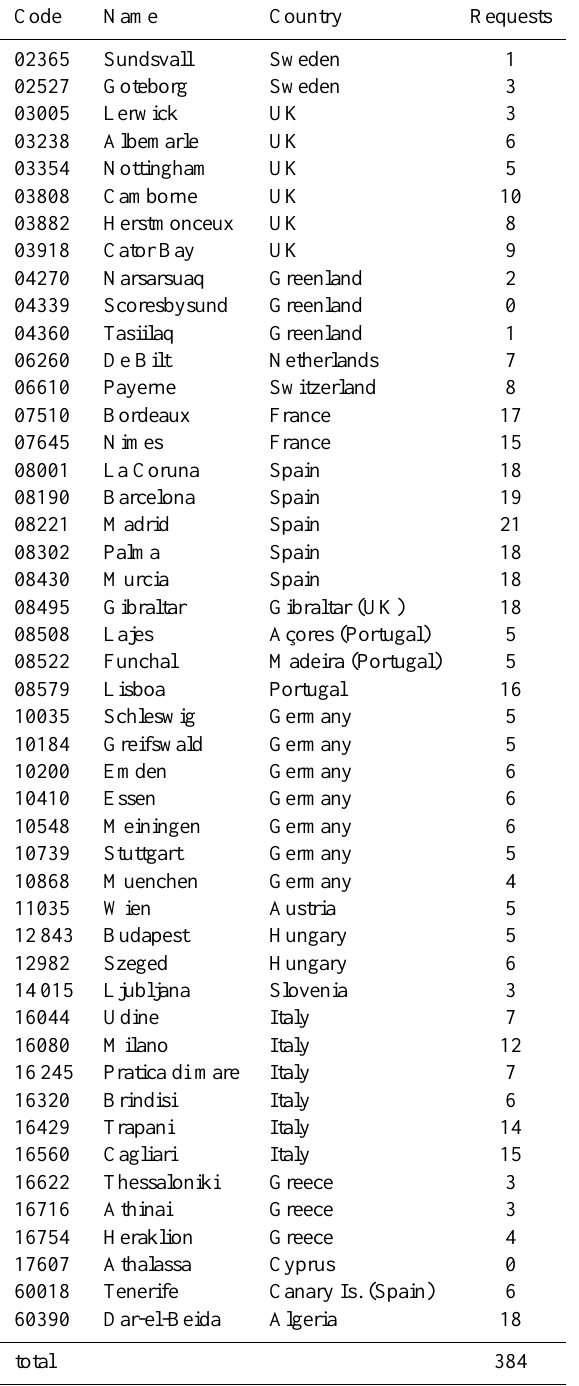
Table 2. Targetable radio-sounding stations and frequencies of extra-soundings requested (proxy of the